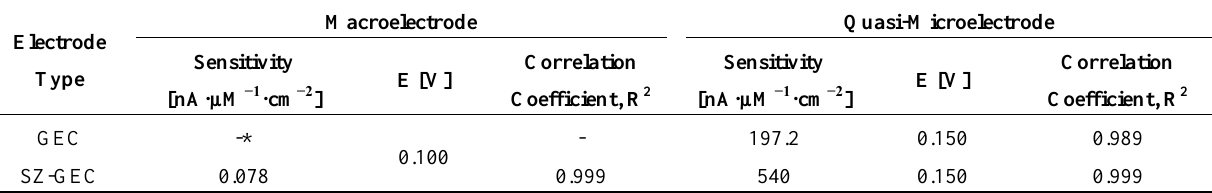
Table 5. Analytical parameters obtained with CPA techniques for DA concentration range between 10 and 50 µM at macroelectrodes and between 25 nM and 1 µM at quasi-microelectrodes.